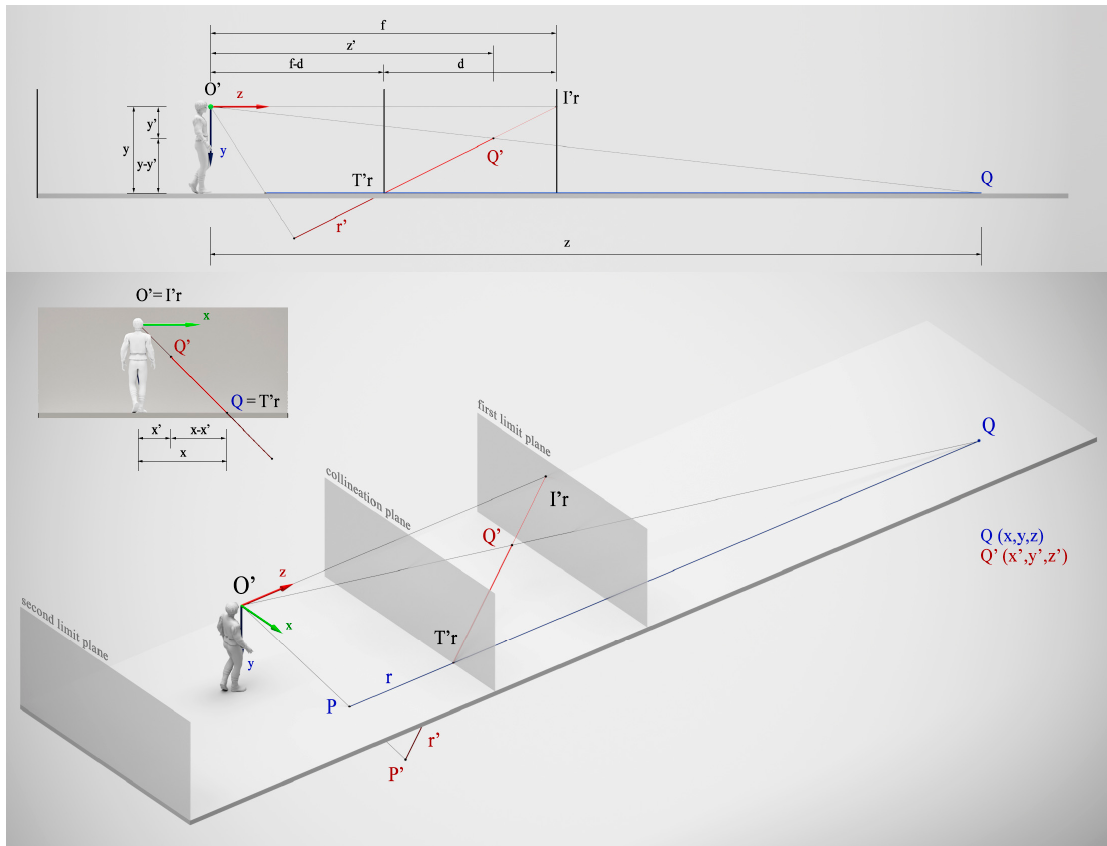
Figure 3. Main elements of a relief perspective and geometric relationships at the base of the ratio between the coordinates of a point in the affine space and the coordinates of the same point in the projective